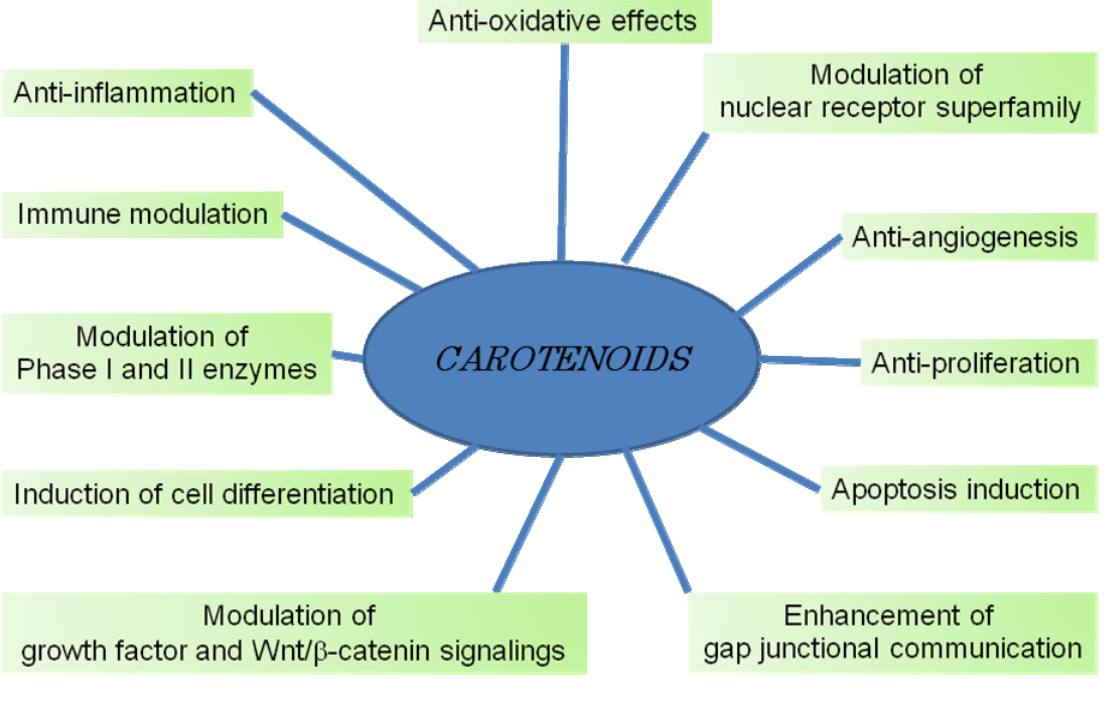
Figure 2. Proposed mechanisms by which certain carotenoids suppress